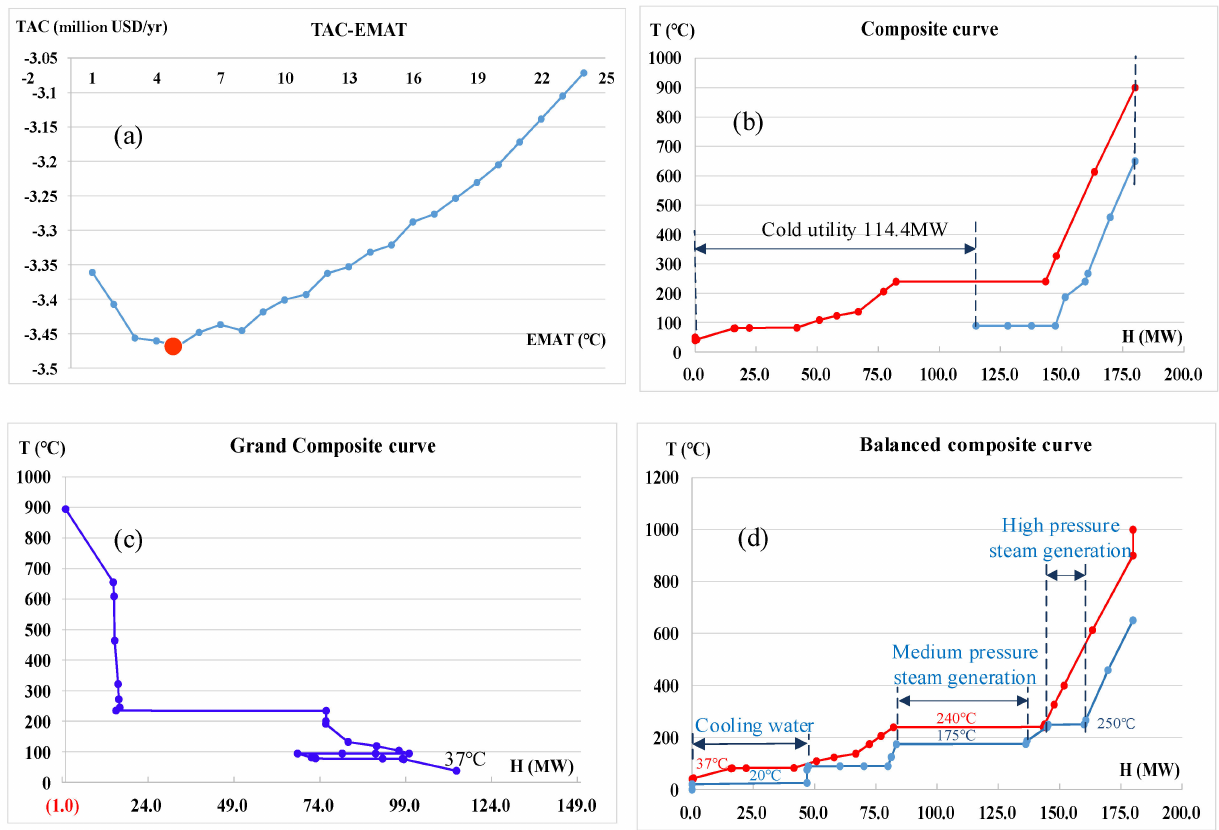
Figure 5. ( a ) TAC vs. ∆ T min , ( b ) cold and hot composite curves, ( c ) grand composite curve, and ( d ) balanced composite curve of DRU + MSU. (Note: in figures ( b , d ), red line represents hot compound curve; blue line represents cold compound